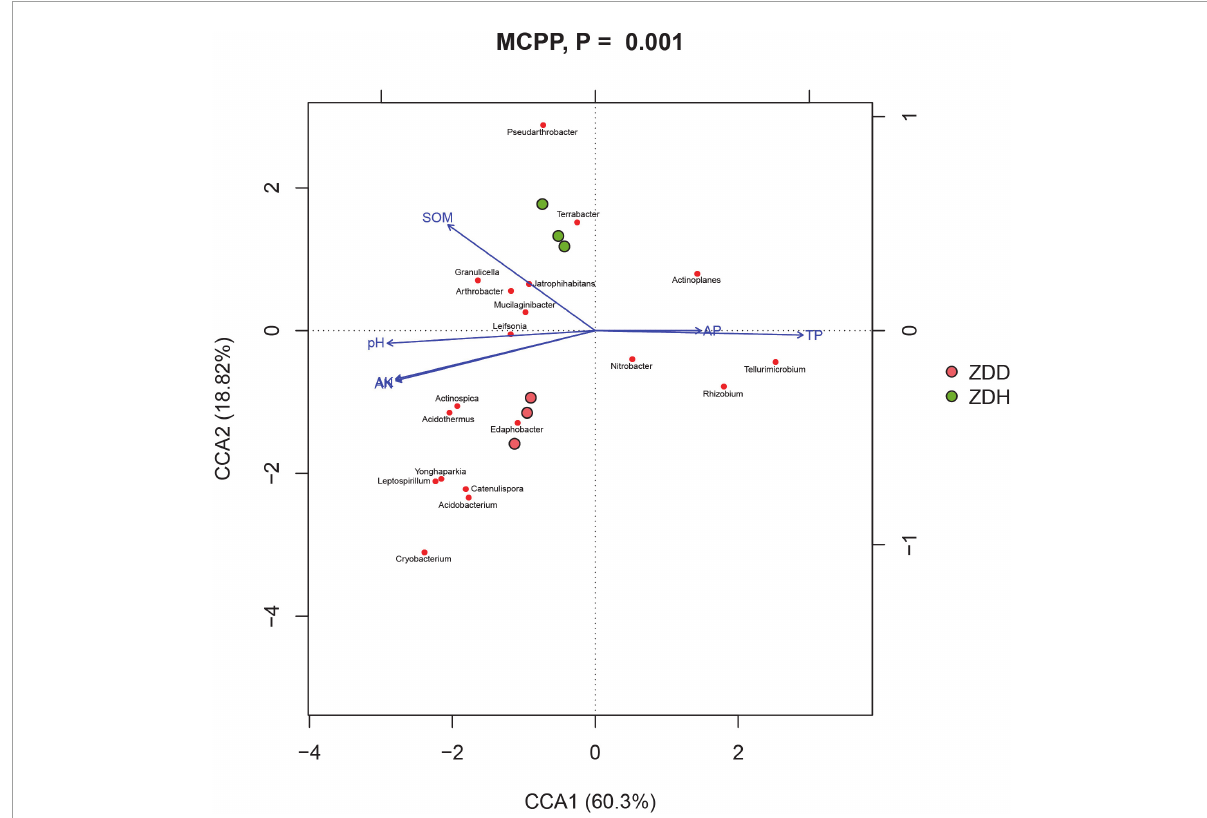
FIGURE6 Canonical correspondence analysis (CCA) between the soil and bacterial community in maize rhizosphere soil. ZDD refers to rhizosphere soil with severe stalk rot disease, and ZDH refers to the rhizosphere soil with disease-free near by the ZDD.